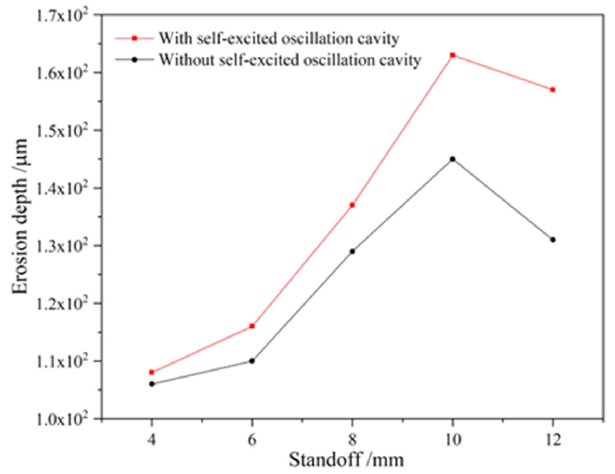
Figure 15. Erosion depth influences curves under different standoffs.